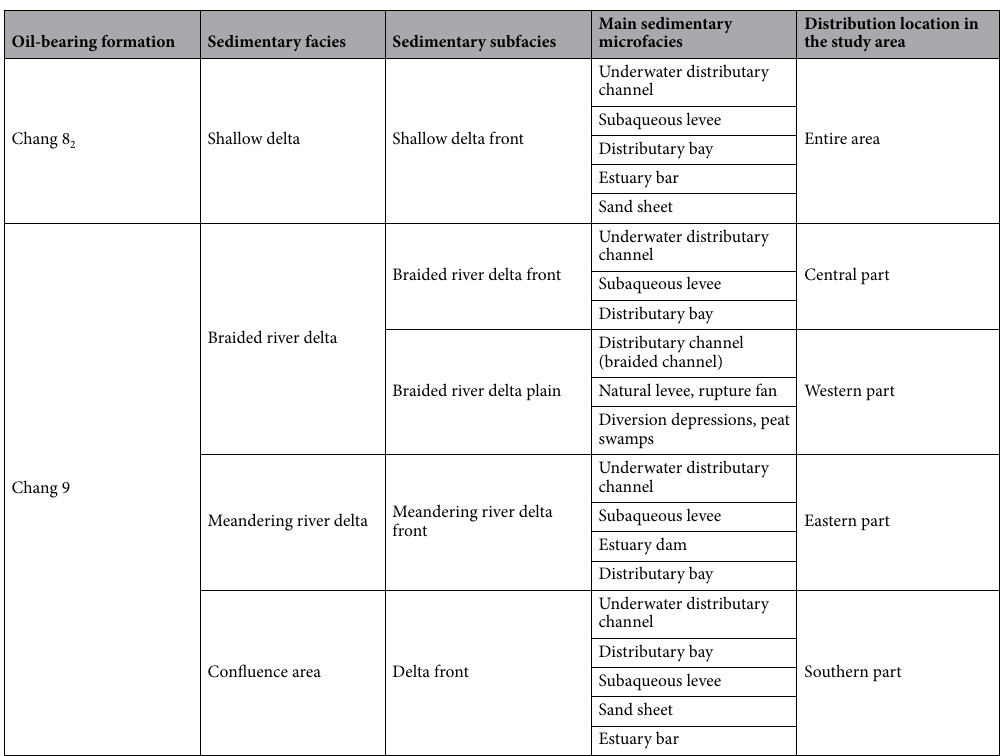
Table 2. Composition and distribution of sedimentary facies types in the sub-oil-bearing Chang 82 formation and the oil-bearing Chang 9 formation.